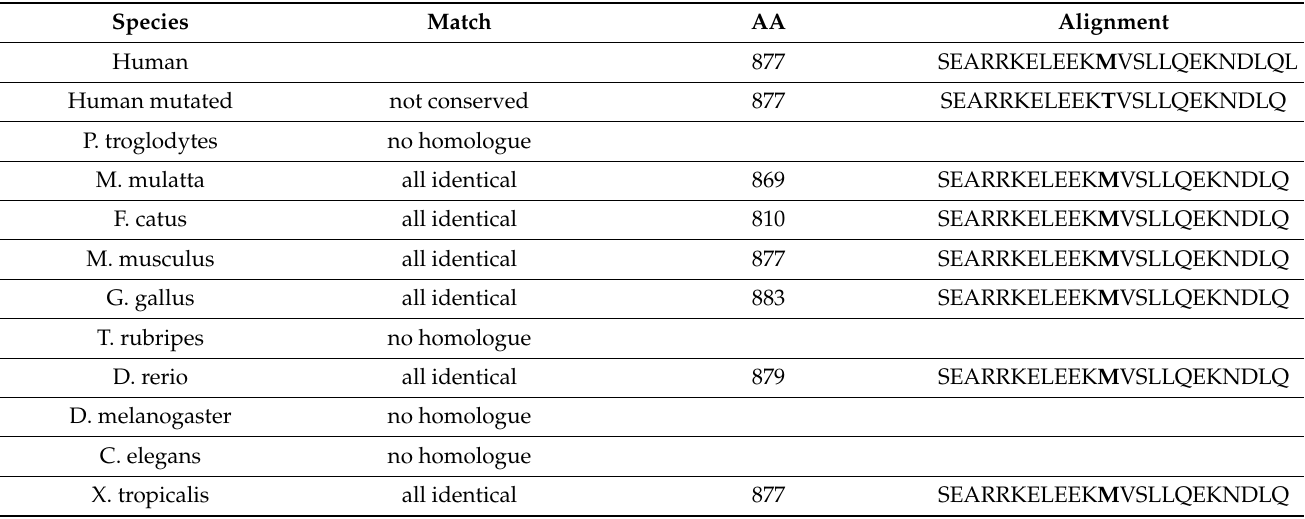
Table 3. Multiple protein sequence alignment of amino acid 877 in MYH7 .